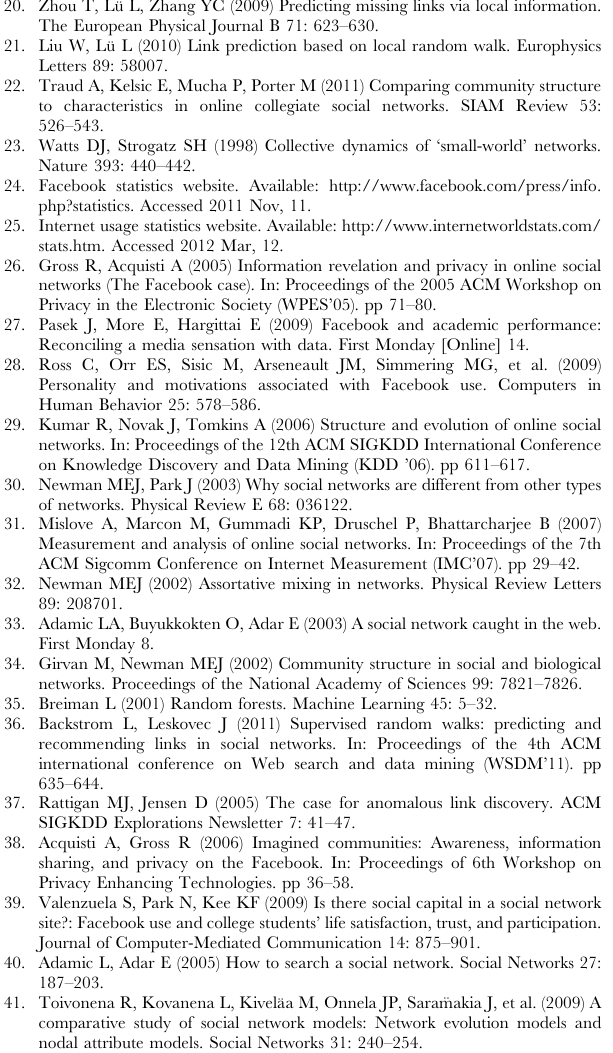
samples to do the learning; black squares denote data points where PPV k was smaller than the according fraction of positive samples among all samples. Table S1 Percentage of edges between two non-mem- bers that commonly know at least one member of all edges between two non-members. Shown is the average of ten runs for r ~ 0 : 5 and a ~ 0 : 5 : (PDF) Text S1 Details about the experimental setting. (PDF)